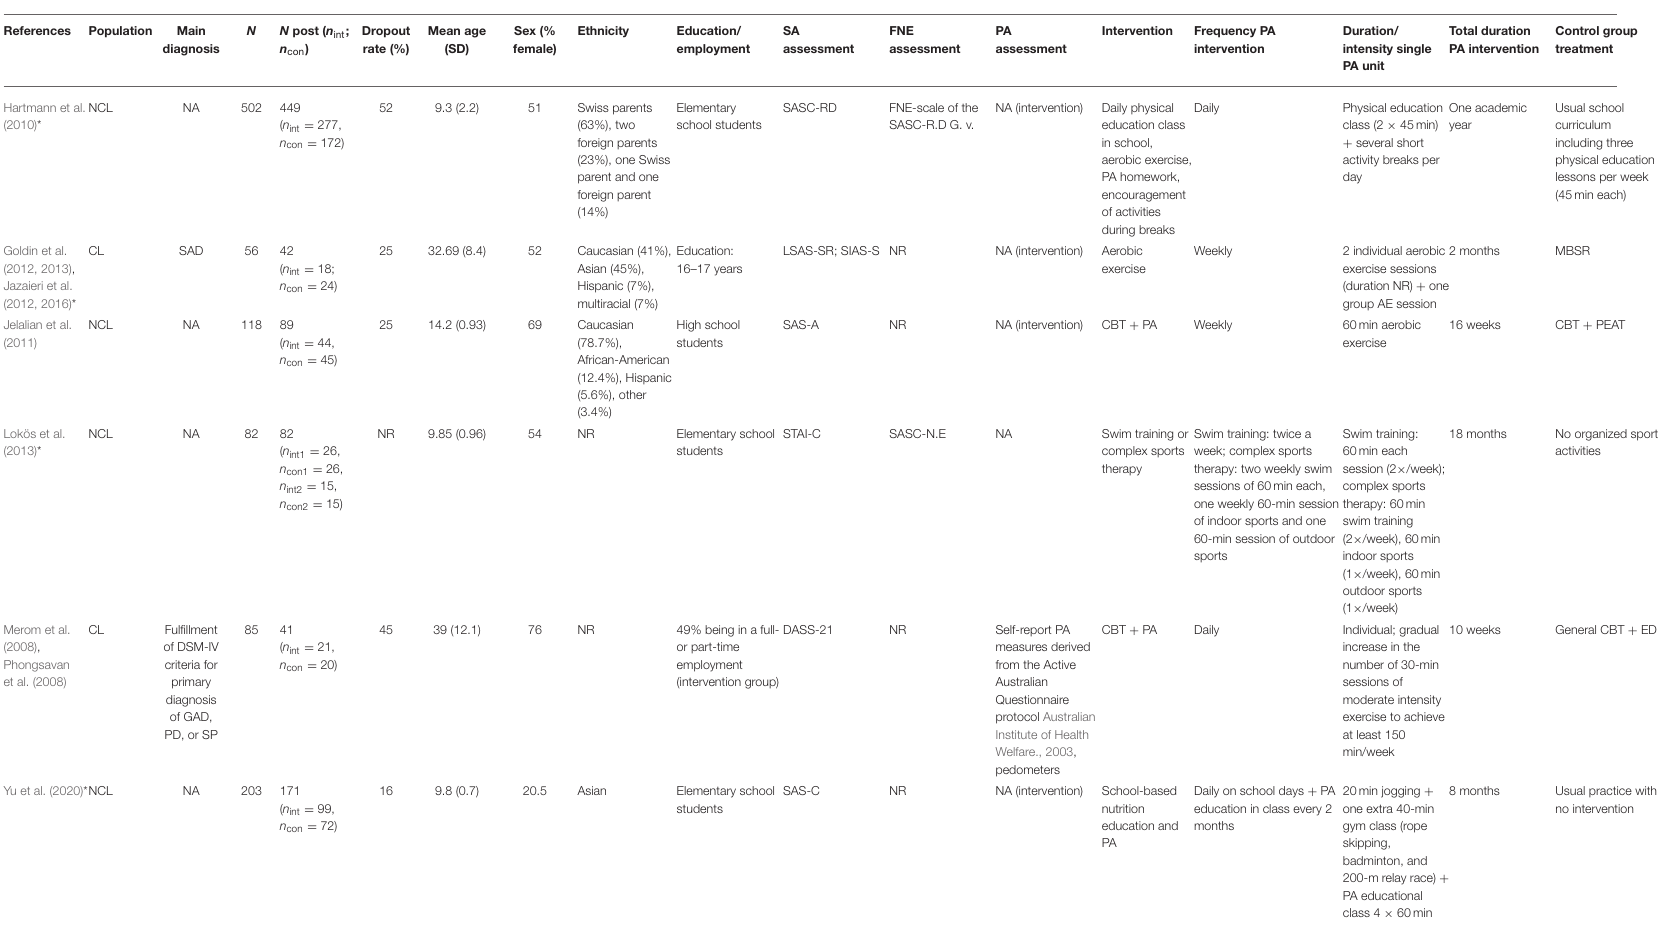
TABLE 1 | Characteristics of the randomized controlled